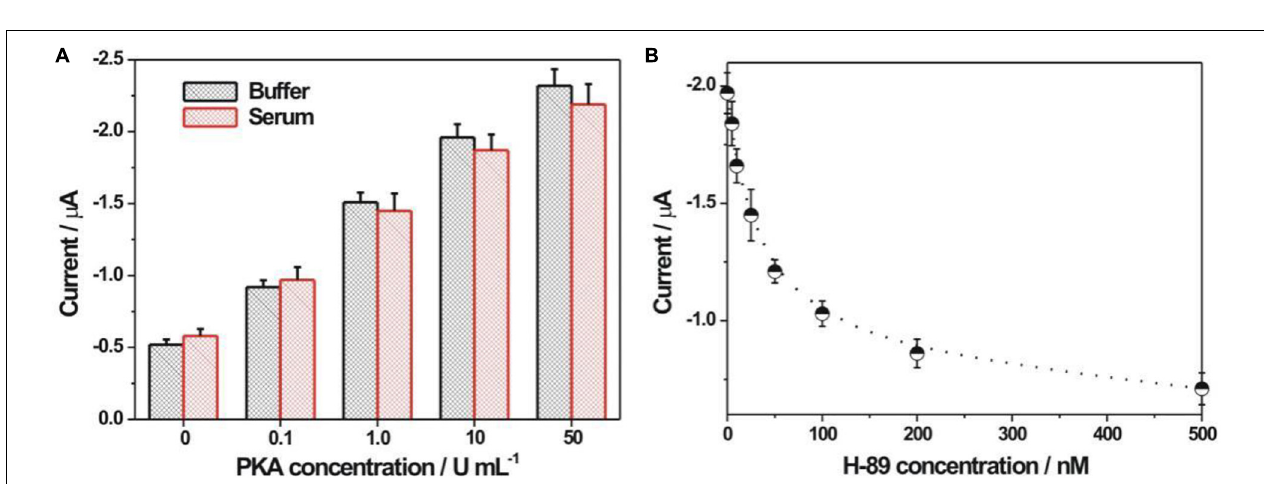
FIGURE 6 | (A) Electrochemical detection of PKA in buffer and 5% diluted FBS. (B) Electrochemical responses at different H-89 concentrations. The H-89 concentrations were 5, 10, 25, 50, 100, 200, and 500 nM, respectively. The concentrations for PKA and ATP were 10 U/mL and 100 µ M, respectively.